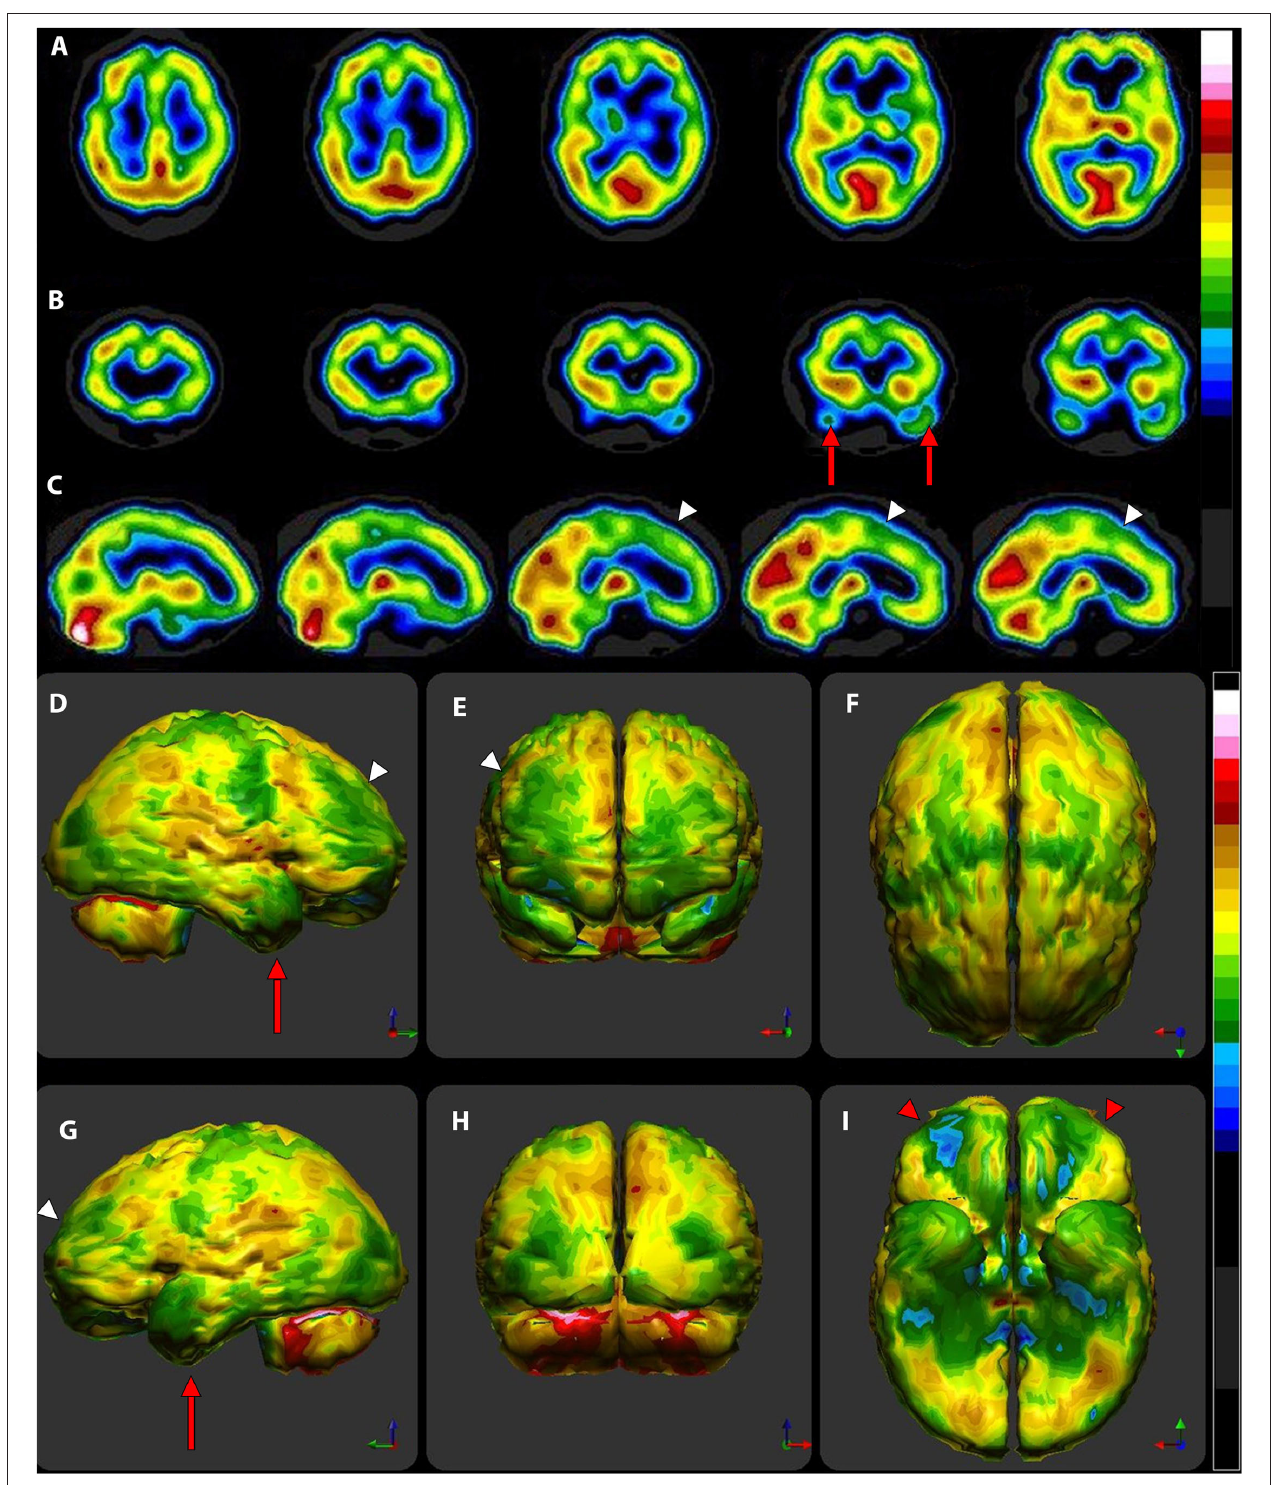
FIGURE 9 | Tomograms and 3-D surface projections of perfusion SPECT scan showing mild TBI. (A) Selected transverse sections. (B) Selected coronal sections. Decreased perfusion in the temporal lobes is evident (red arrows) (C) Selected sagittal sections. Hypoperfusion is seen in the bilateral frontal cortex with greater involvement of the left side (white arrowheads). (D–I) 3-D surface projection views show the more extensive injury to the temporal (red arrows) and frontal cortices (white arrowheads) and scattered involvement of the bilateral parietal cortices. Marked hypoperfusion is seen in the orbitofrontal cortex (red arrowheads). (D) Left lateral view. (E) Anterior view. (F) Superior view. (G) Right lateral view. (H) Posterior view. (I) Inferior view with cerebellum removed. Hypoperfusion is evident in the orbitofrontal cortices bilaterally (red arrowheads). Color scale is the Ubiq40 color scale as described in Figure 5 .